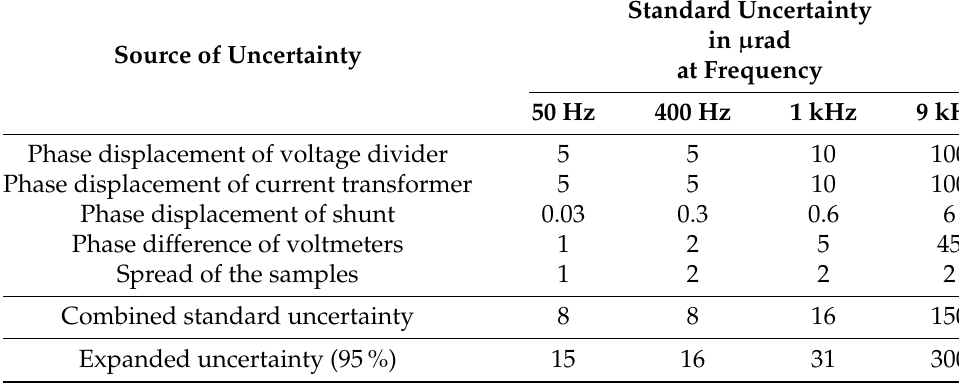
Table 10. Extended system: Uncertainty of the displacement